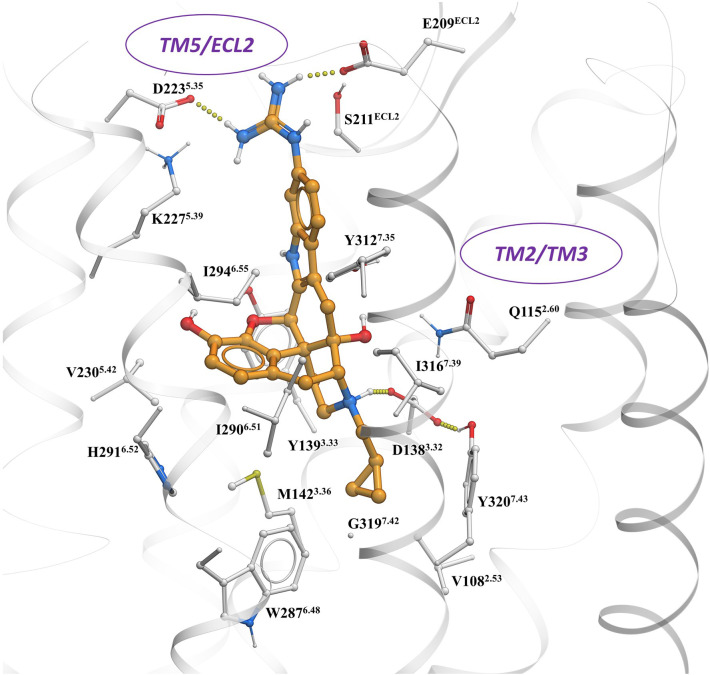
The preferred docking pose of known KOR biased ligand 6′GNTI (chair form, orange stick) at an active state of KOR with the guanidino group engaging a region between TM5 and ECl2.Note: possible engagement of residues D223 and E209 similar to MP1207 and MP1208 in TM5-ECL2 region.